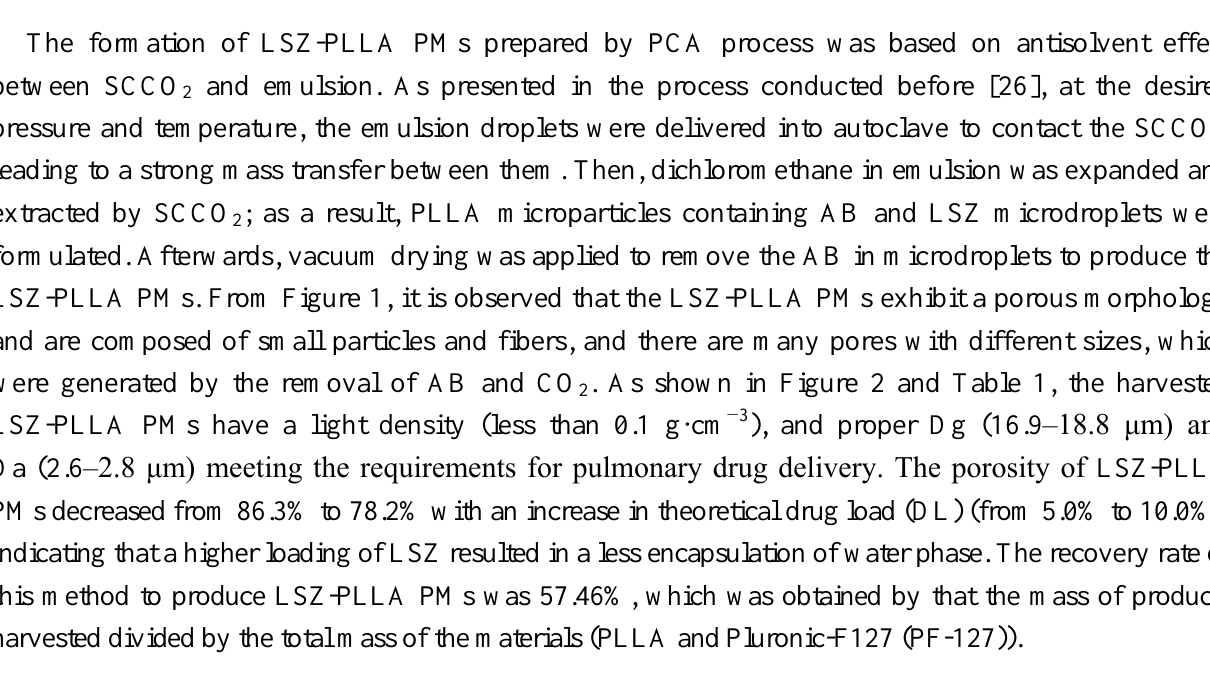
Figure 1. SEM images of lysozyme (LSZ)-loaded poly- L -lactide (PLLA) porous microparticles (PMs) (LSZ-PLLA PMs): ( a ) with magnification of 2.50 k; ( b ) with magnification of 7.00